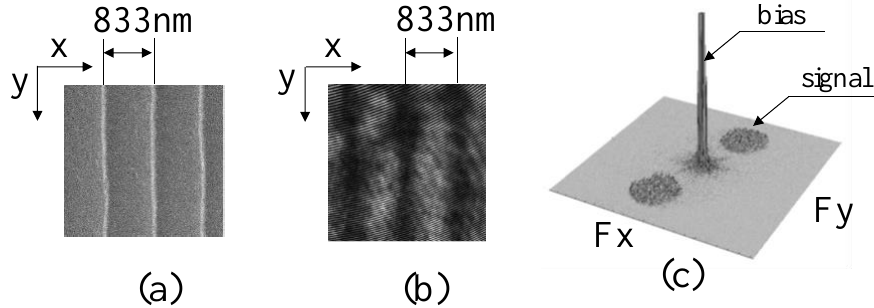
Figure 4. One-dimensional analysis ( a ) SEM image of measured object; ( b ) Speckle pattern; ( c ) Speckle pattern in frequency domain.